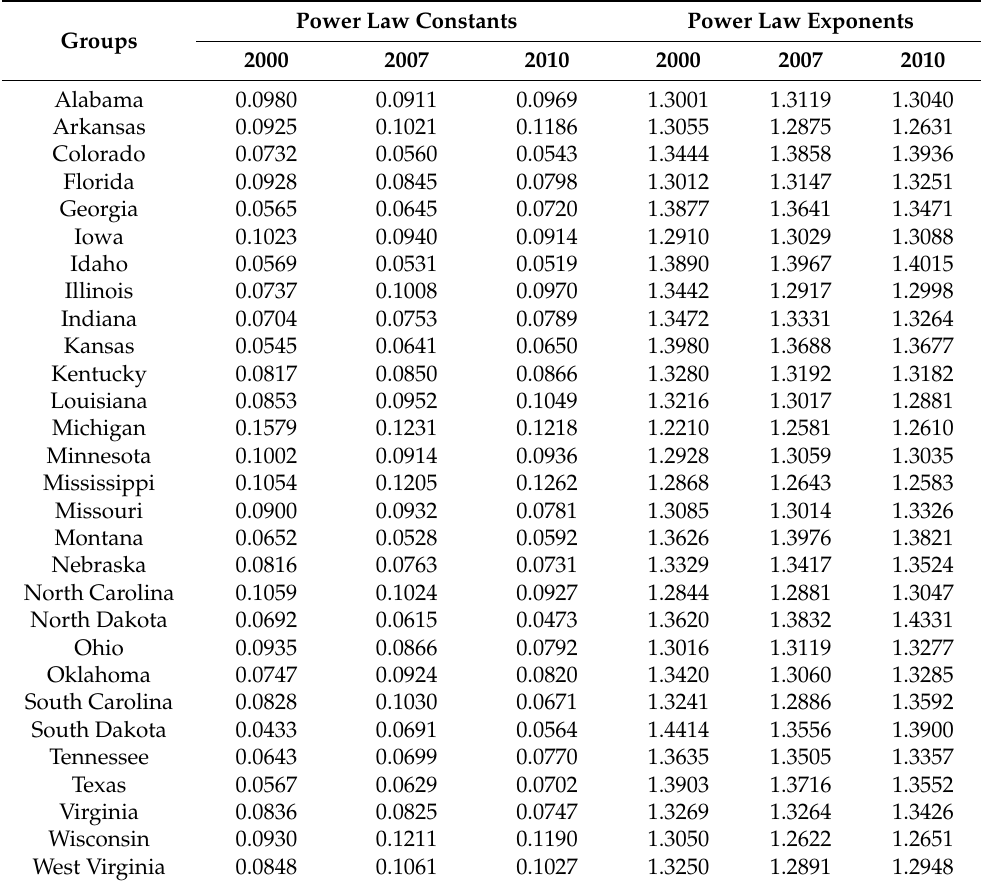
Table 11. Power law characteristics in 2000, 2007, and 2010 for the existing entrepreneurship–total entrepreneurship relationships of county groups in different U.S.